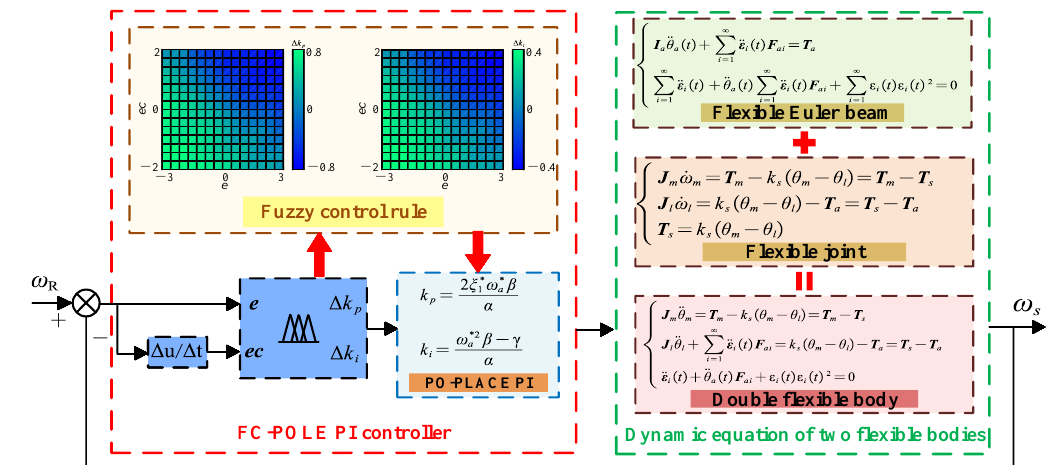
Figure 5. Improved fuzzy PI control block diagram of double flexible body system.